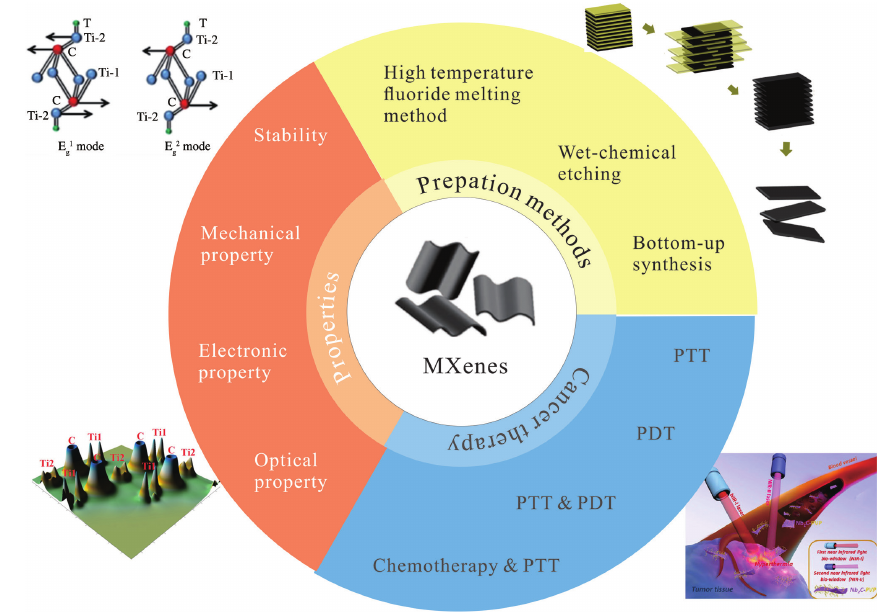
Figure 2: Applications of MXenes in cancer